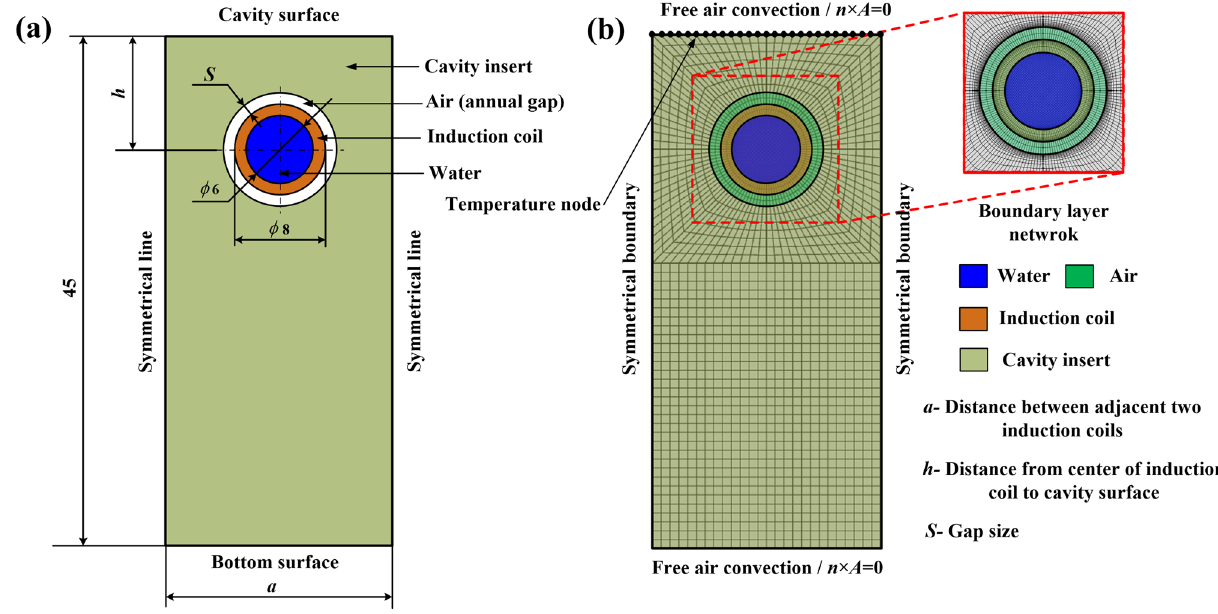
Fig. 2 Unit cell model ( a ) and corresponding mesh model ( b ) for mold thermal response analysis